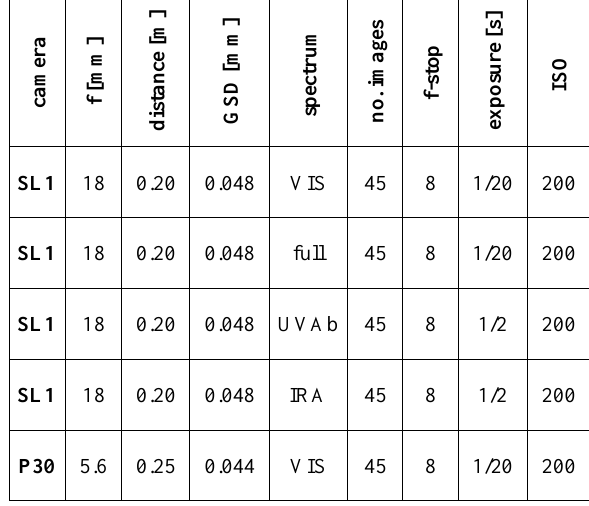
Table 2: details of image datasets for OBJ1